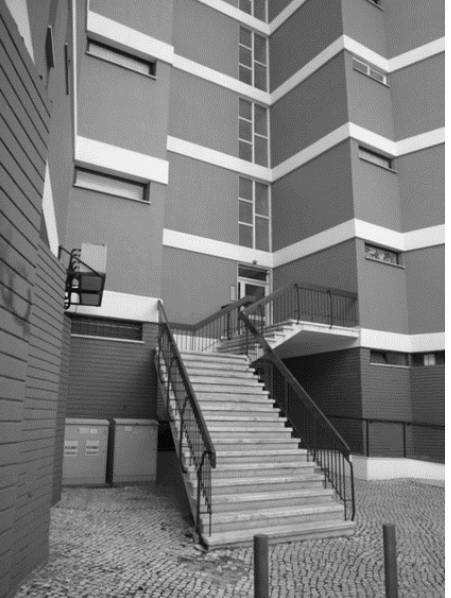
Figure 20. Stairs of the principal entrance.